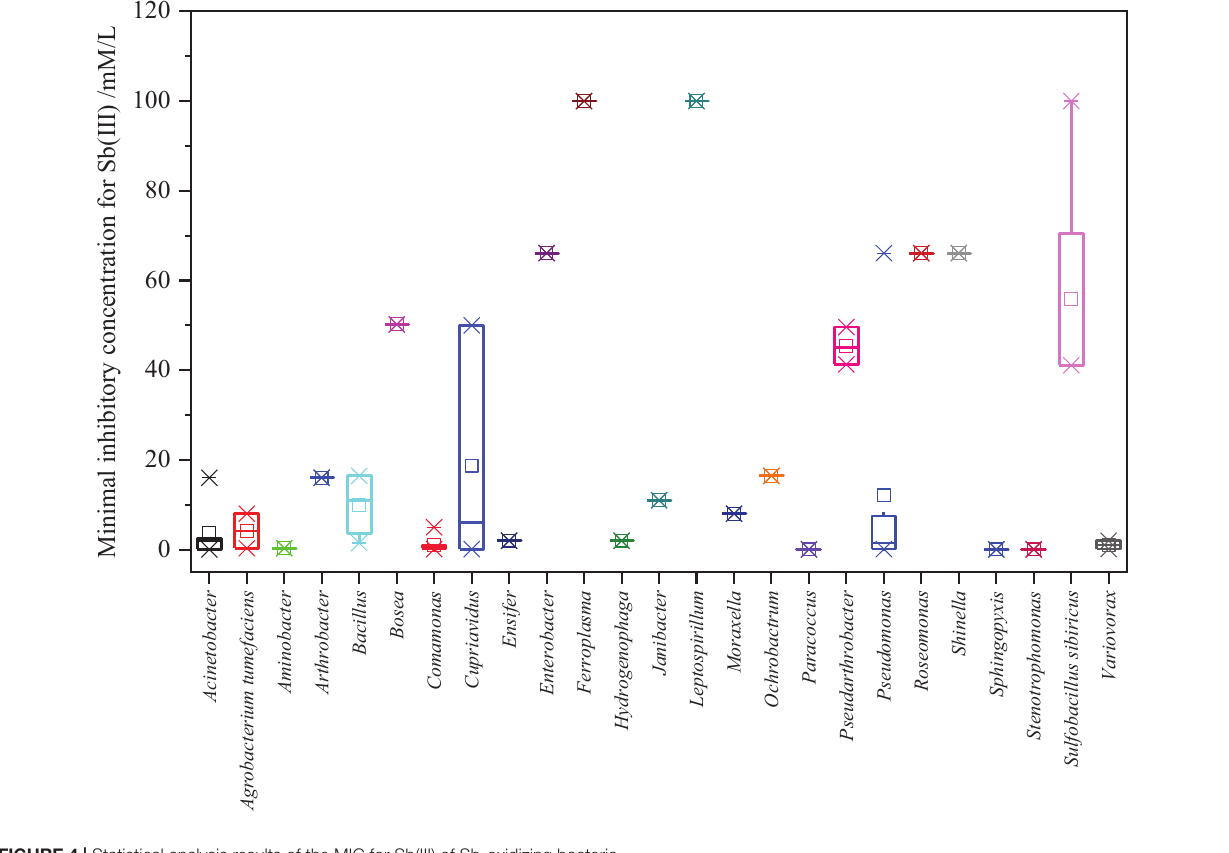
Leishmania cell membranes, and AQP7 and AQP9 aquaporin also facilitate Sb(III) across mammalian cells. Recently, Gu et